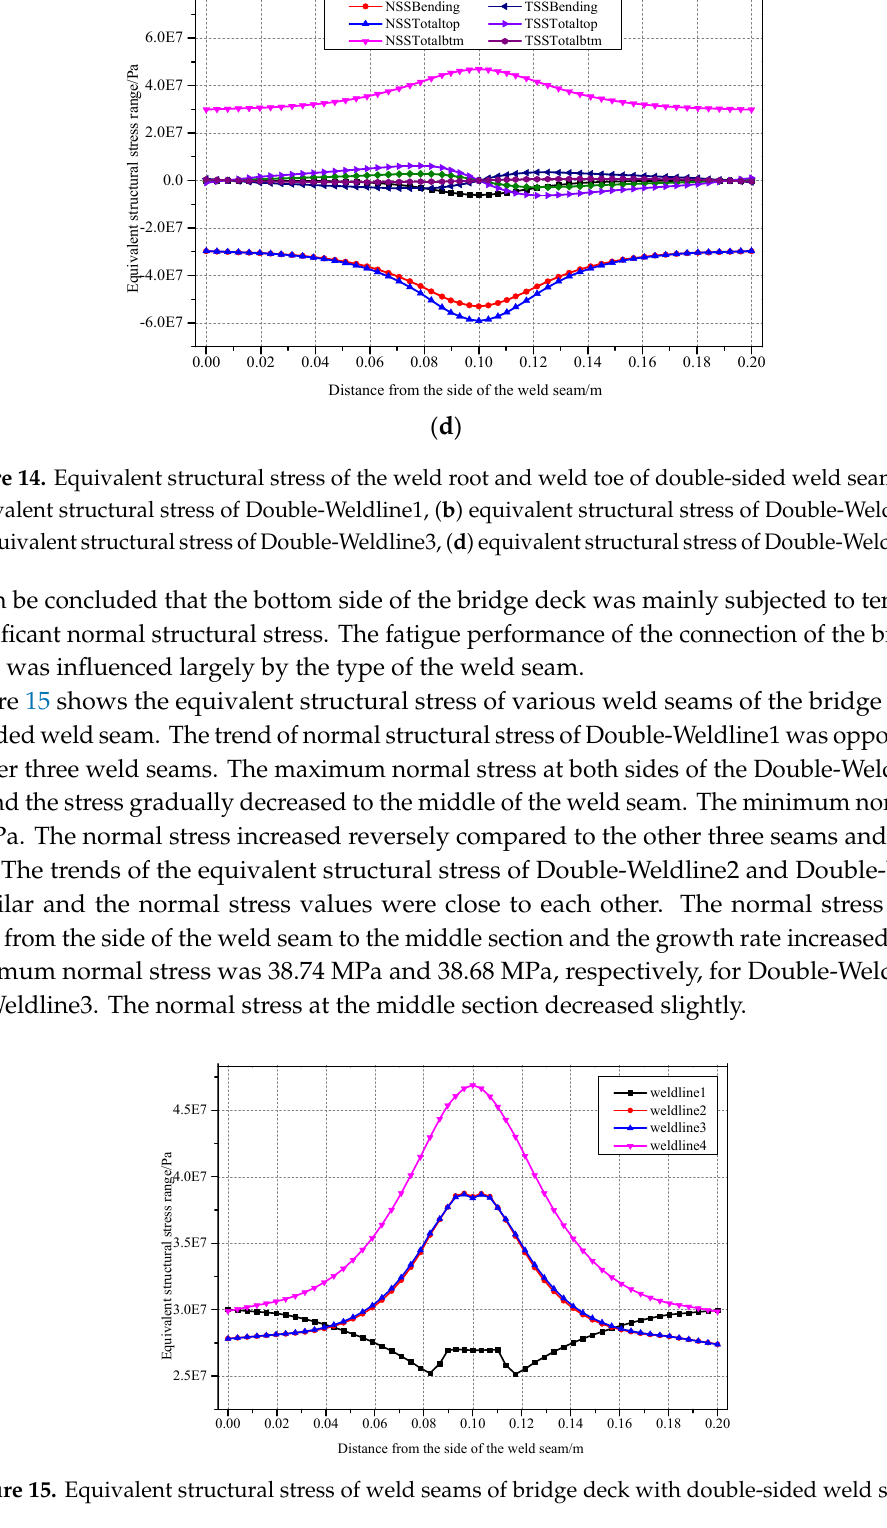
Figure 15. Equivalent structural stress of weld seams of bridge deck with double-sided weld seam.